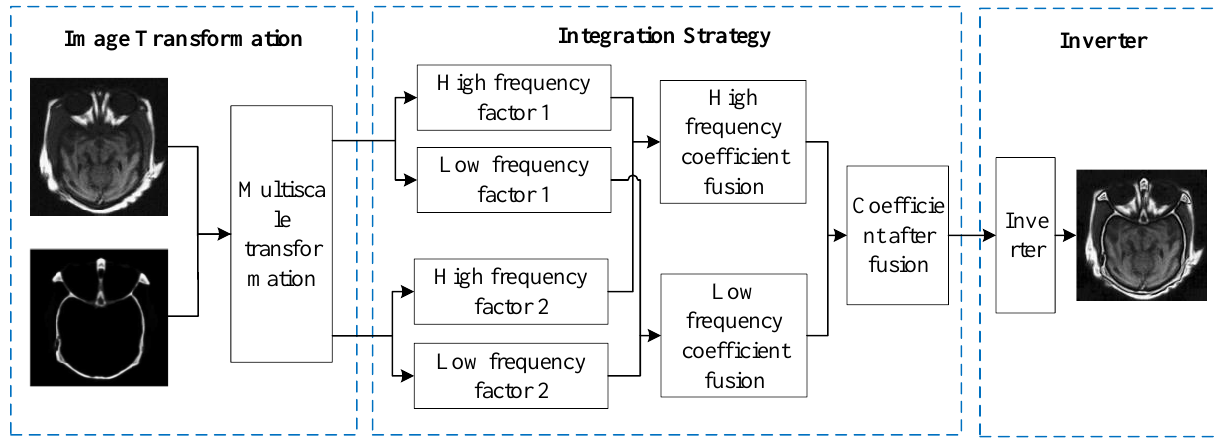
Figure 1. Multiscale transform-based image fusion framework.